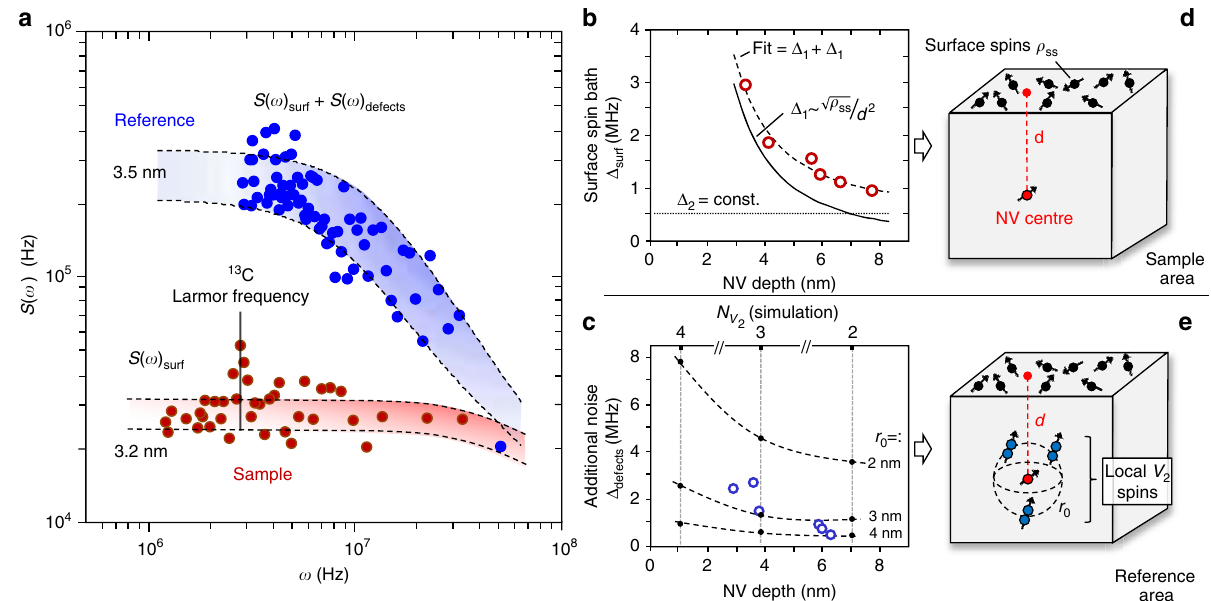
Figure 4 | Suppressed magnetic noise for NVcentres. ( a ) Noise spectra sensed by two NVcentres located at the ‘Sample’ and ‘Reference’ areas at similar depths ( B 3nm), as derived from coherence decay (CPMG pulse sequence, N ¼ 32 p -pulses) by means of spectral decomposition technique. The dashed curves and shadowed areas establish margins for fitting the spectra by Lorentzian functions. ( b ) Extracted coupling strength as a function of depth for NV centres in the ‘Sample’ area. The dashed curve is a two-component fit comprising the model of surface spin bath 40 (solid curve (1)) and a constant noise contribution (dotted curve (2)). ( c ) The additional noise component (defects coupling strength) extracted from NV centres in the ‘Reference’ area is shown as blue dots. The black dots connected by the dashed curves represent the margins of the noise coupling strength calculated for different numbers of di-vacancy electrons spins. These margins were calculated assuming the simplified modelled NV– V 2 configuration depicted in panel ( e ), which represents residual defects after nitrogen implantation and thermal annealing (see text and Supplementary Note 1 for details). ( d , e ) Schematic representations of the resulting spin systems around a single implantation-induced NV centre at the ‘Sample’ and ‘Reference’ areas,